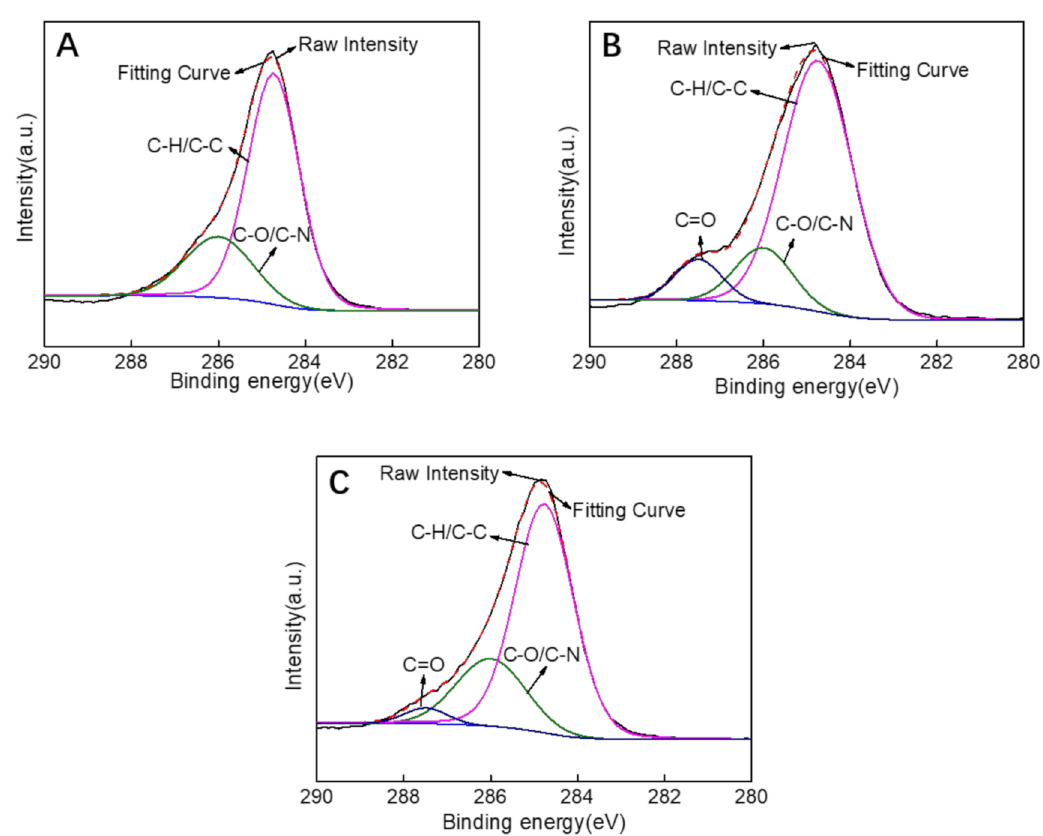
Figure 8. XPS C1s spectrum of PES substrate ( A ), M3 (PDA/PEI-10000) membrane ( B ), M3/AGQDs- 0.2 membrane ( C ).